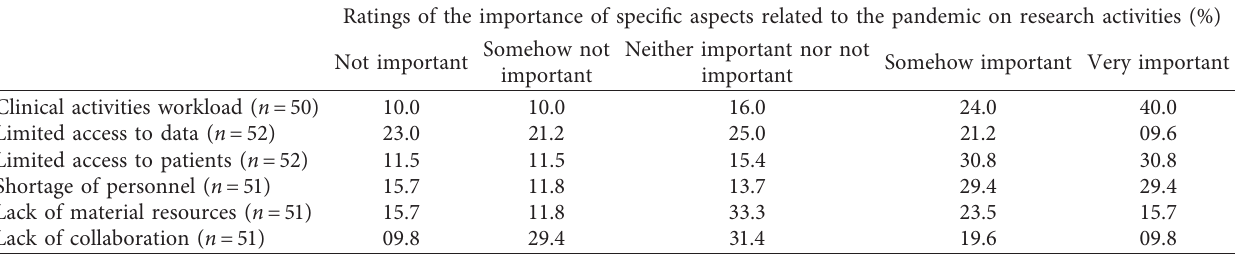
Table 3: Importance of the impact of COVID-19 pandemic on the preexisting research activities of faculty members. Ratings of the importance of specific aspects related to the pandemic on research activities (%) Somehow not Neither important nor not Not important important